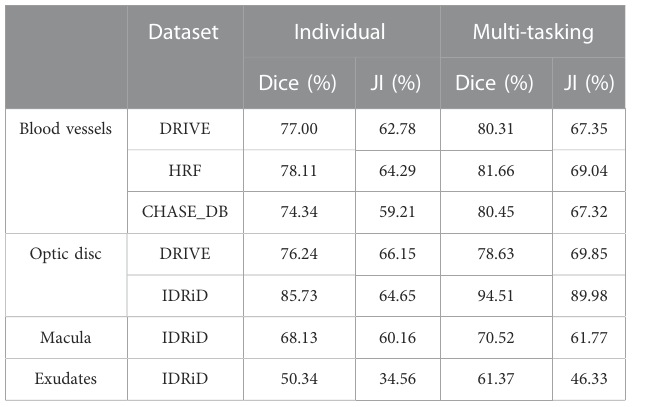
TABLE 1 Comparison of results with and without multi-tasking. For all tasks excepttheopticdisc,multi-taskingwasdonewiththeODasanauxiliarytask.For the OD, multi-tasking was done in combination with blood vessels.